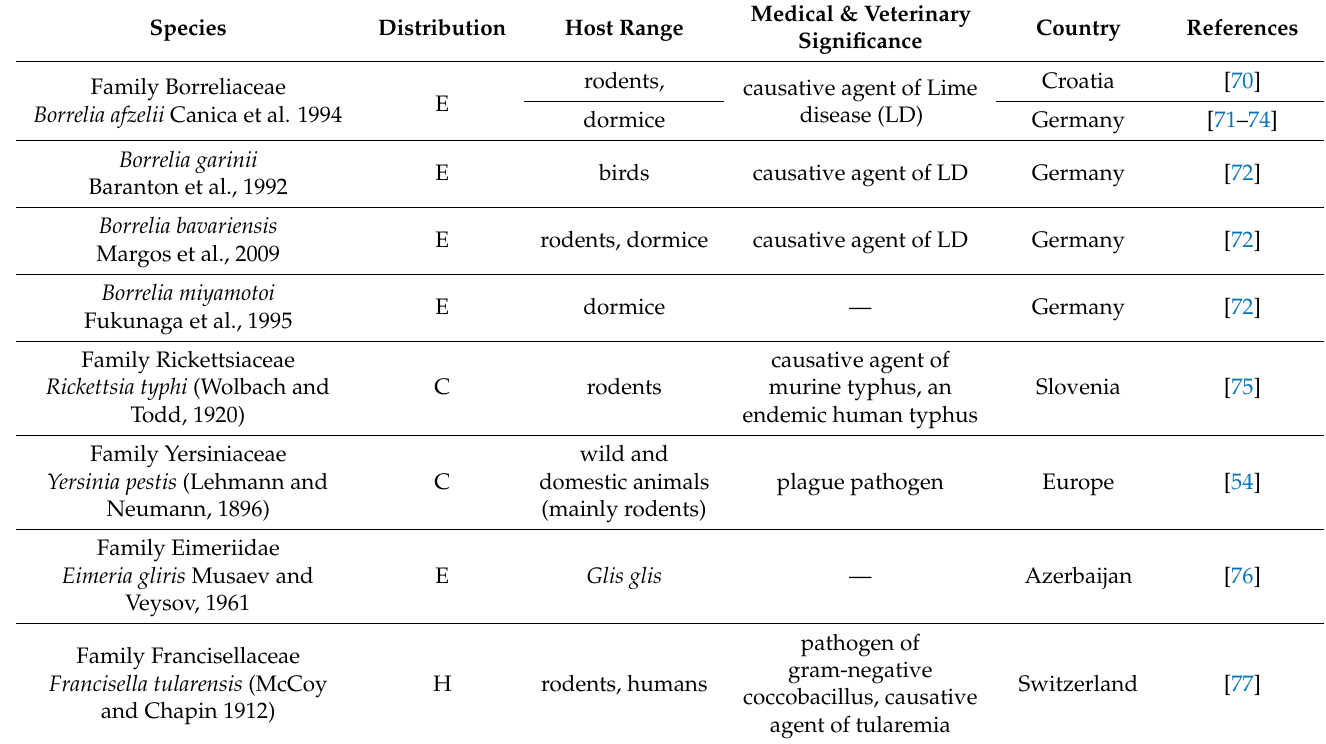
Table 2. Protozoa of Glis glis in Western